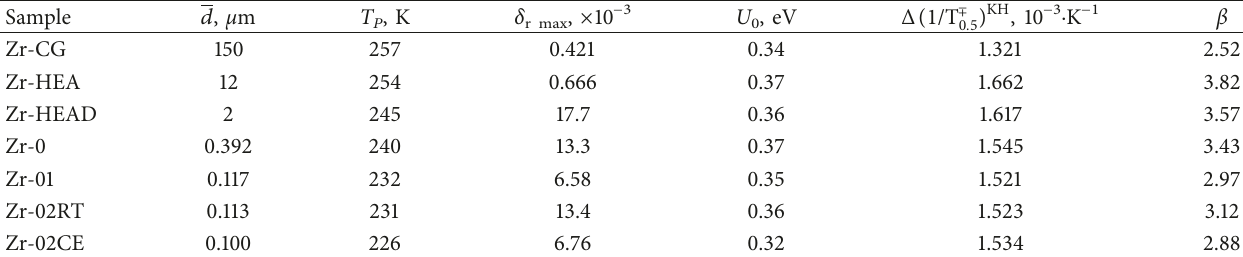
Table 2: The main parameters of the KH peak in the as-prepared samples.